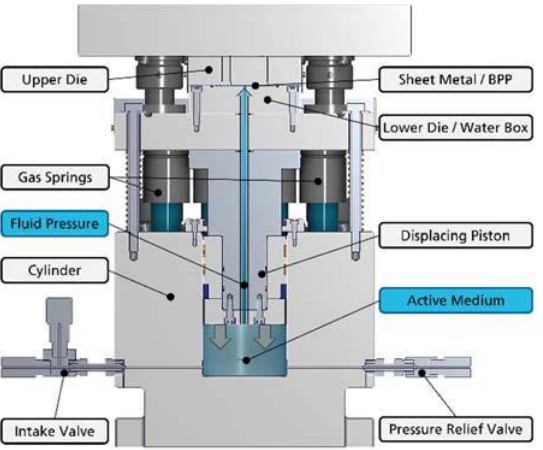
Figure 3. Cross section of a tool for passive hydroforming during pressure-build-up phase.